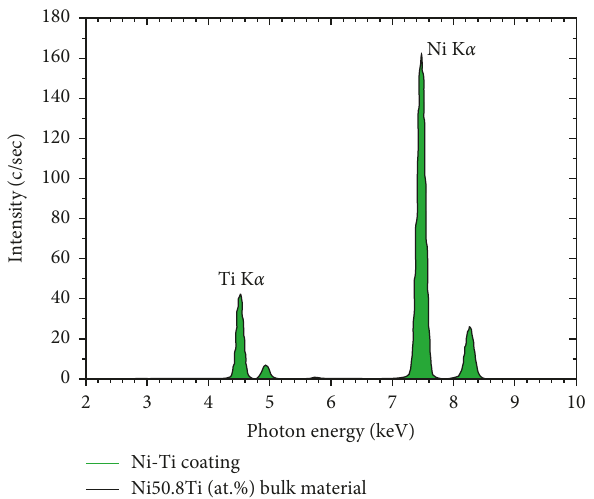
Figure 7: Ni and Ti K X-ray transitions from the NiTinol coating versus the bulk Ni-rich Ni50.8Ti (at.%) sample.